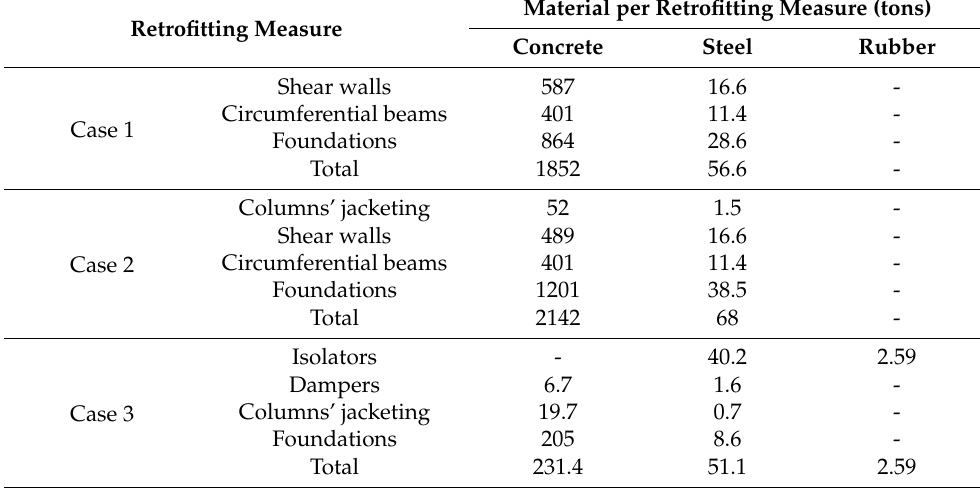
Table 4. Material consumption in Cases 1, 2, and